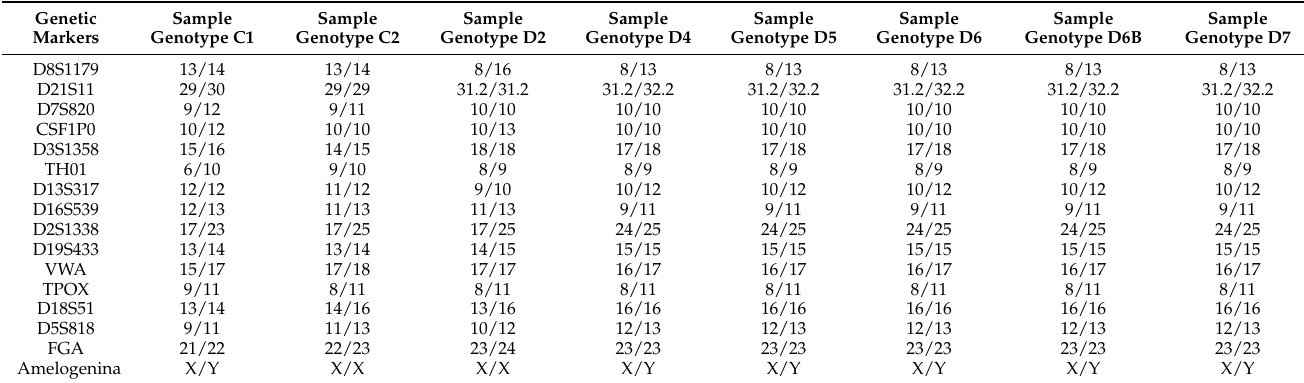
Table 2. Autosomal DNA chromosome polymorphisms results.